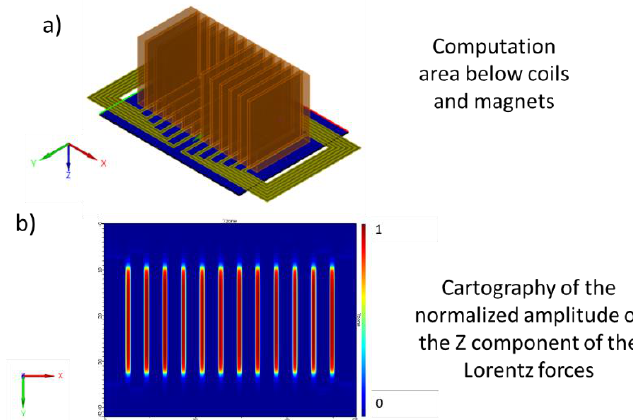
Figure 6. Simulation result. Normalized Z component of the Lorentz forces of the 12-element EMAT in liquid sodium. ( a ): Computation area below the sensor. ( b ): Cartography of normalized amplitude of the Z component of the Lorentz forces.